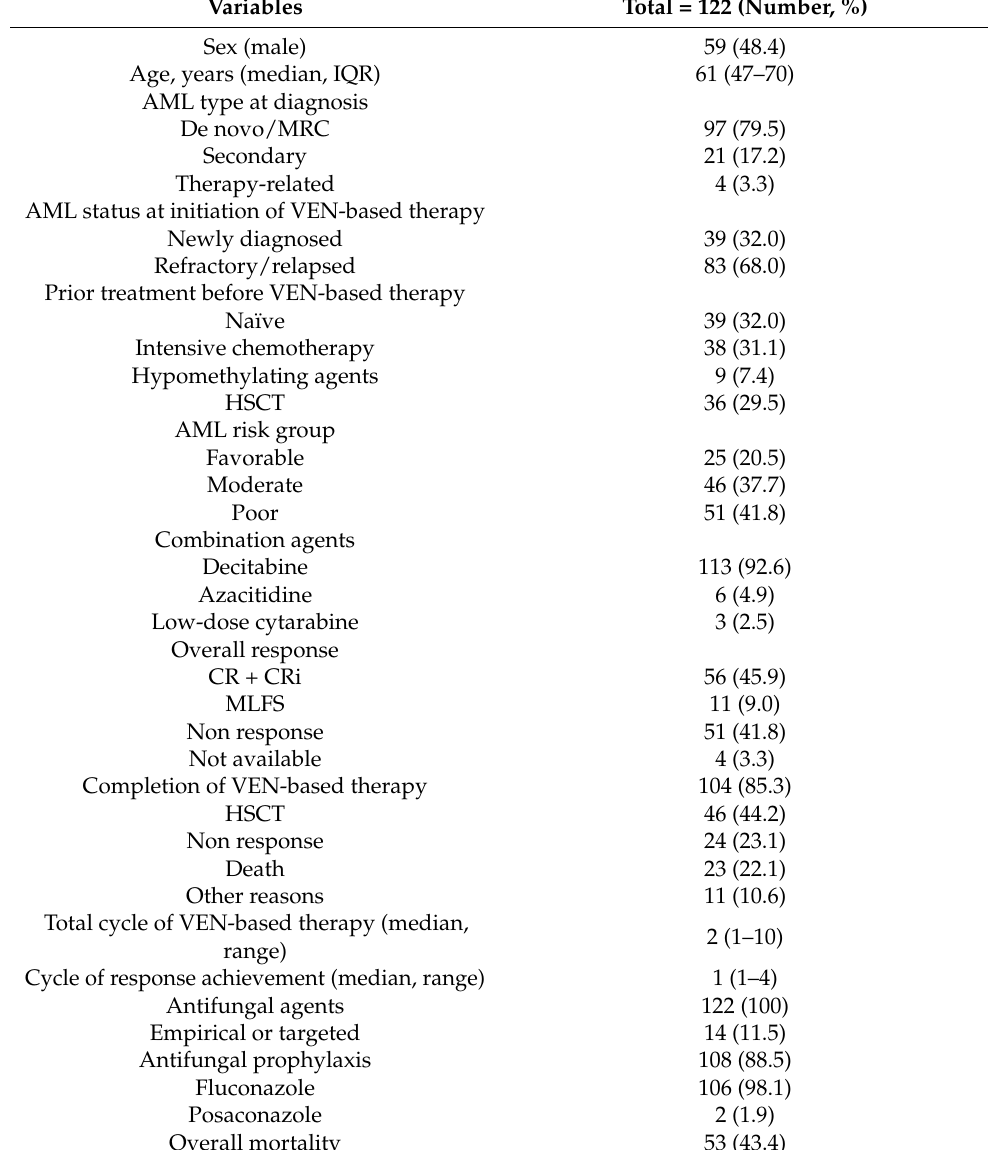
Table 1. Baseline characteristics, prophylaxis, responses, and outcomes of study